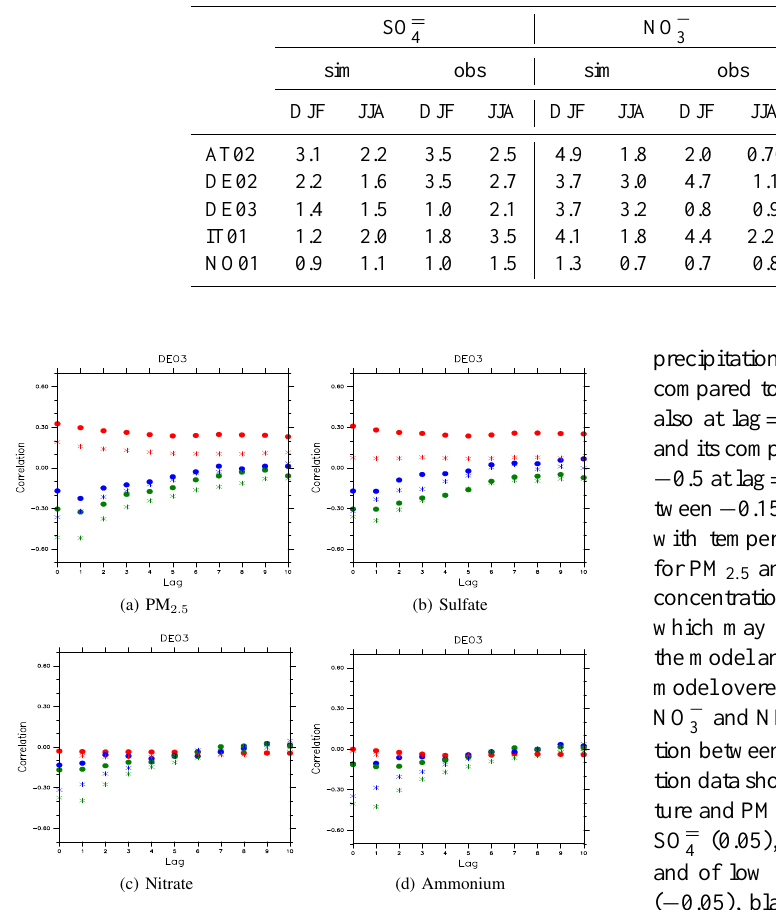
Table 4. Mean simulated (sim) and observed (obs) concentrations of sulfate, nitrate, and ammonium in winter (December-January-February, DJF) and in summer (June-July-August, JJA) at the five stations, expressed inµgm − 3 .